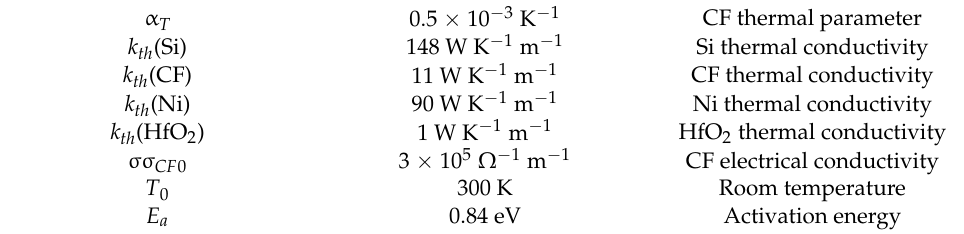
Table 1. Physical parameters used in the